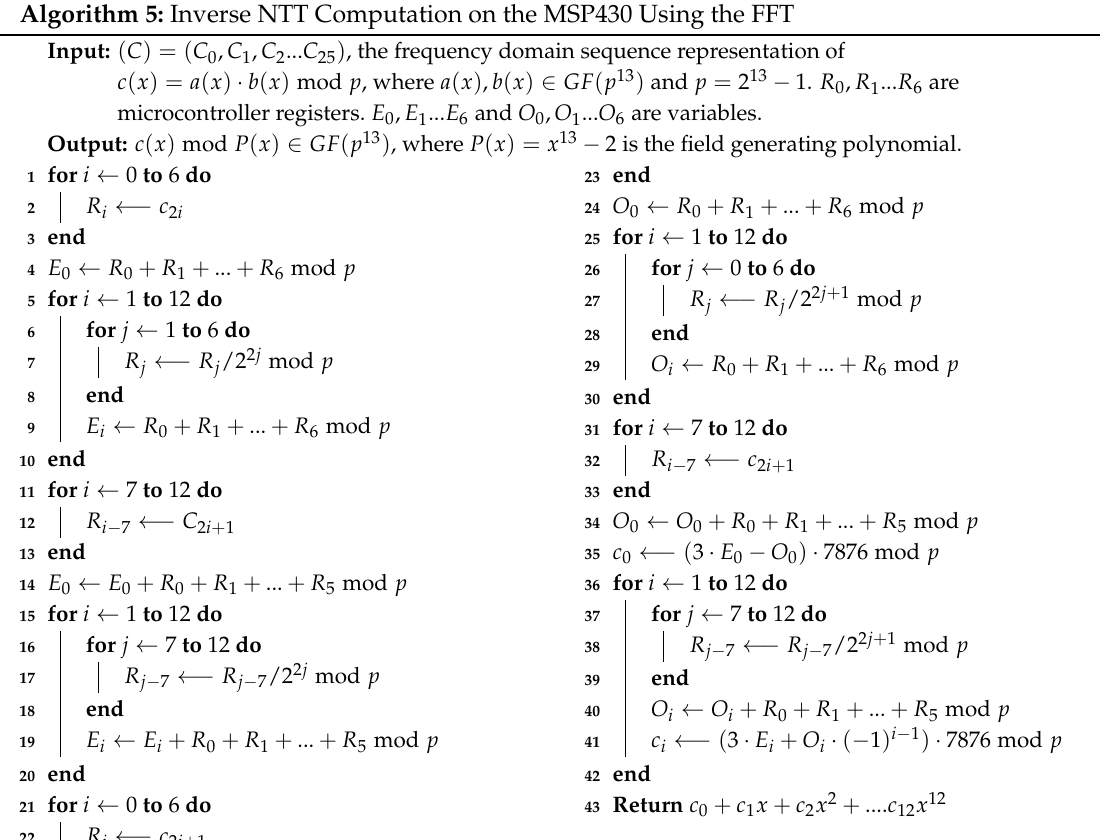
Algorithm 5: Inverse NTT Computation on the MSP430 Using the FFT